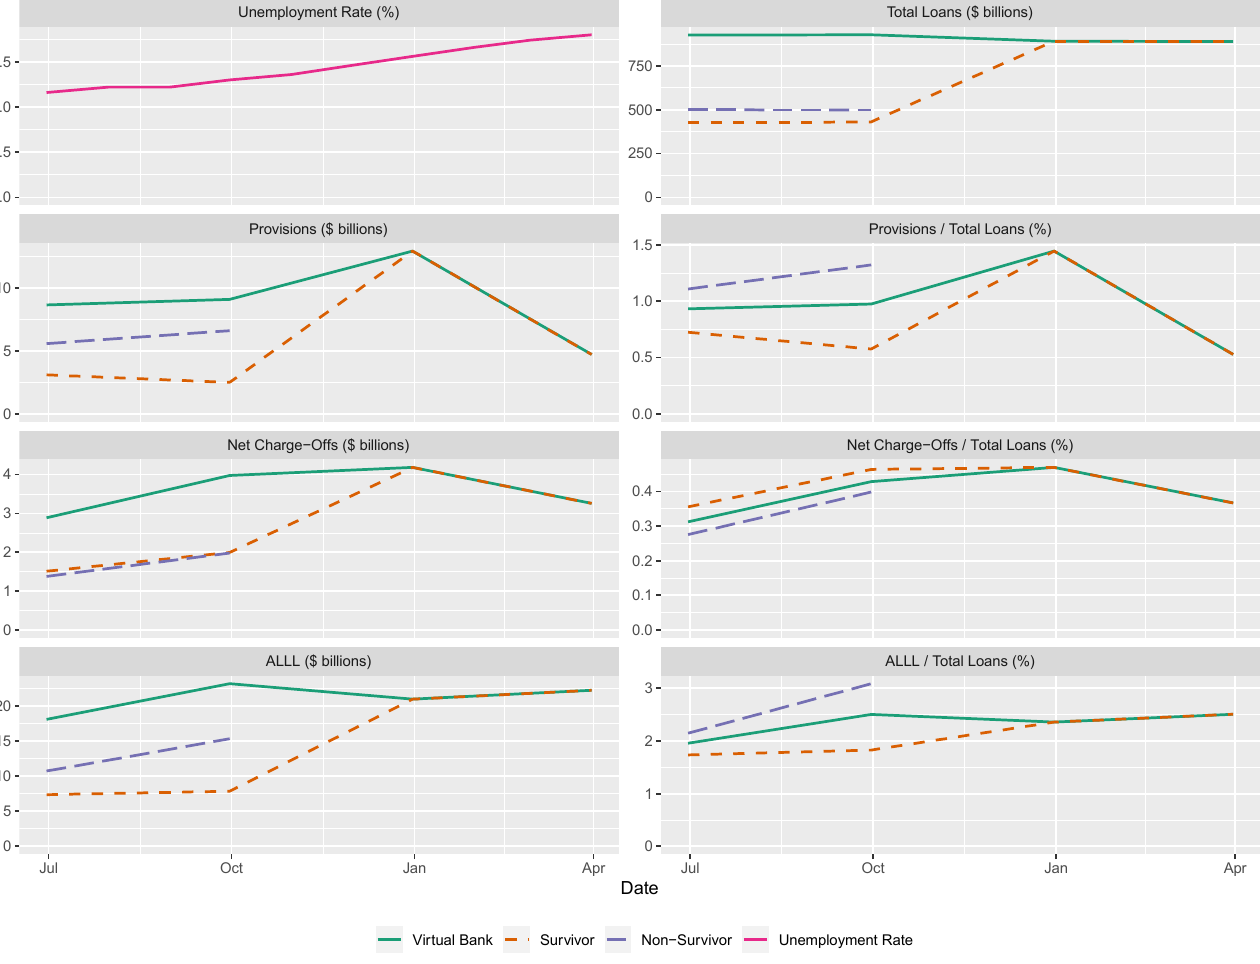
Figure 2. Wells Fargo and Wachovia Merger Adjustment Example.